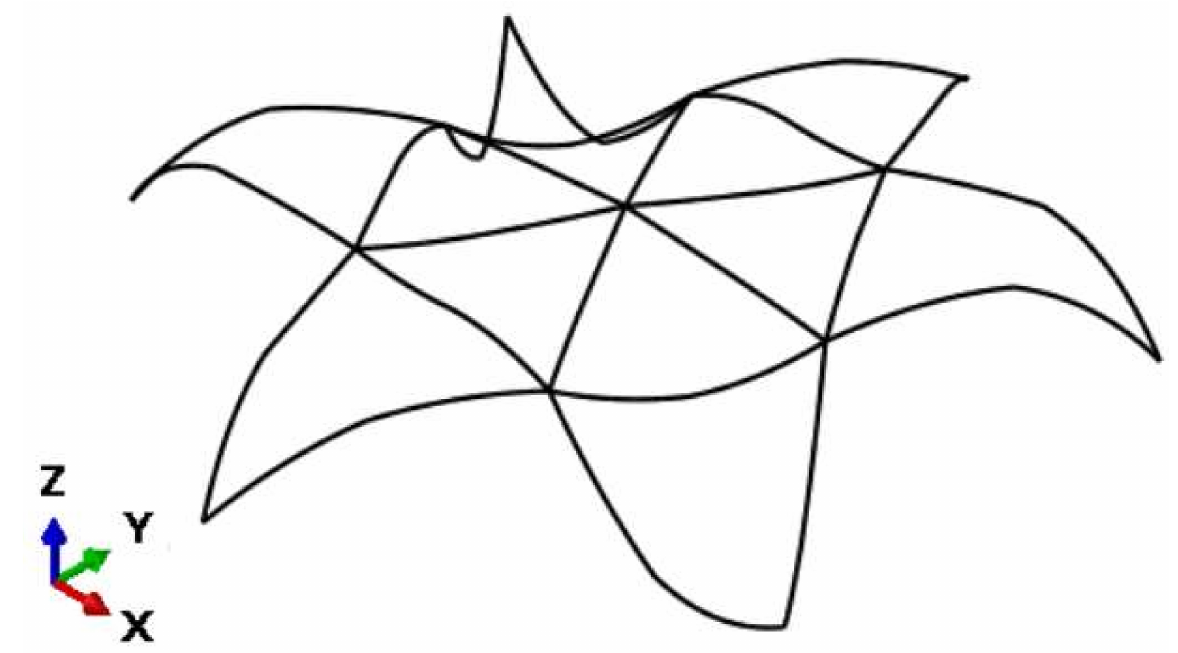
Figure 10. Dome 2—real part of the third nonlinear eigenvector.